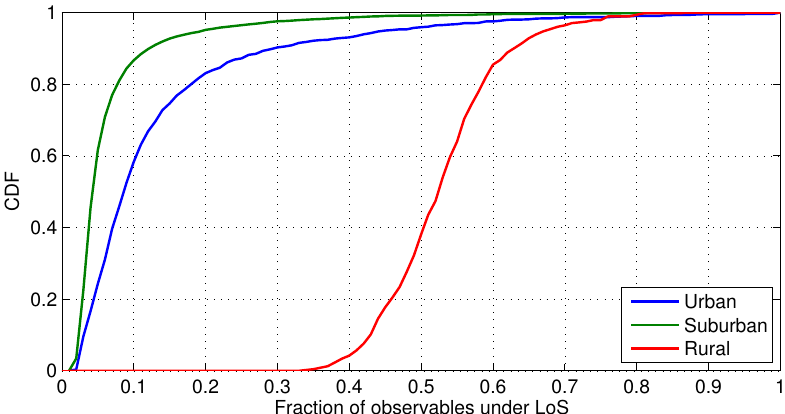
Figure 10. CDF of the fraction of cmWave observables under LoS conditions per